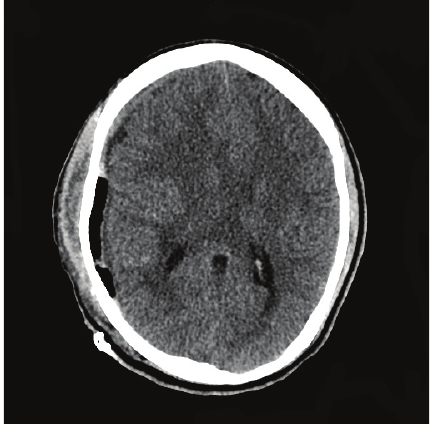
Figure 2: Postop CT showing resolution of epidural hematoma and postop changes on right.